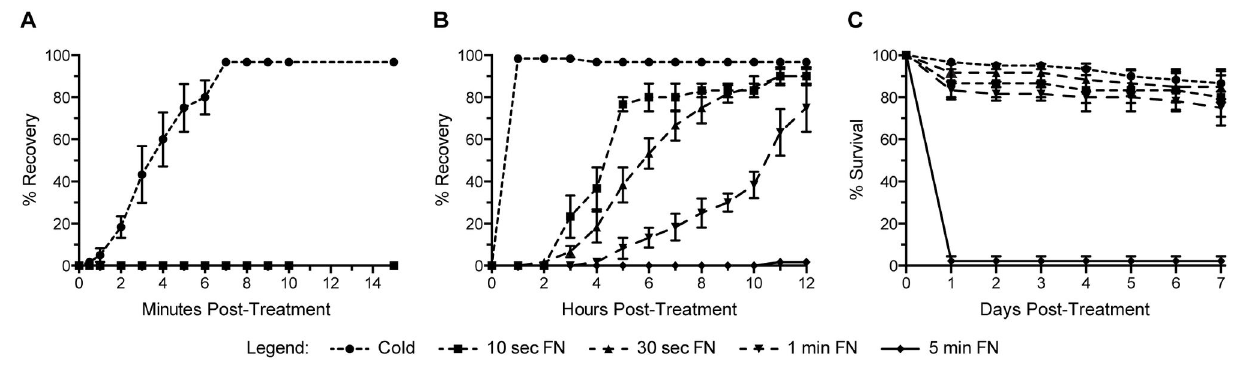
Figure 1. Recovery and survival following cold or FlyNap anesthesia. Mosquitoes were anesthetized by exposure to cold for 60 sec or by exposure to FlyNap (FN) for 10 sec, 30 sec, 1 min or 5 min. (A–B) Percent of mosquitoes that recovered from anesthesia during the first 15 min (A) and 12 h (B) following treatment. (C) Percent of mosquitoes that survived during the first 7 days following anesthesia. Data are the average of 4 trials, each composed of 15 mosquitoes per treatment